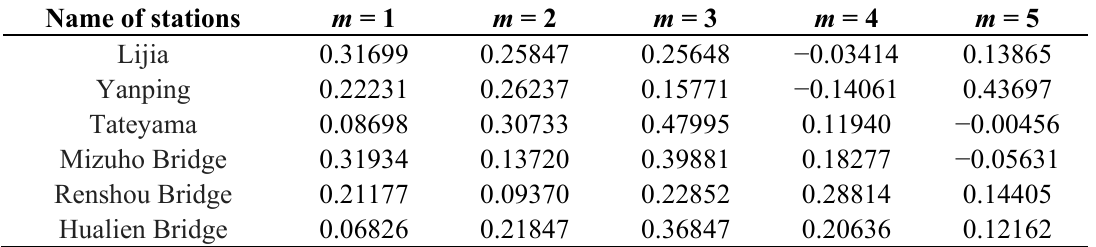
Table 6. The values of the calibrated coefficients in the AR model for six